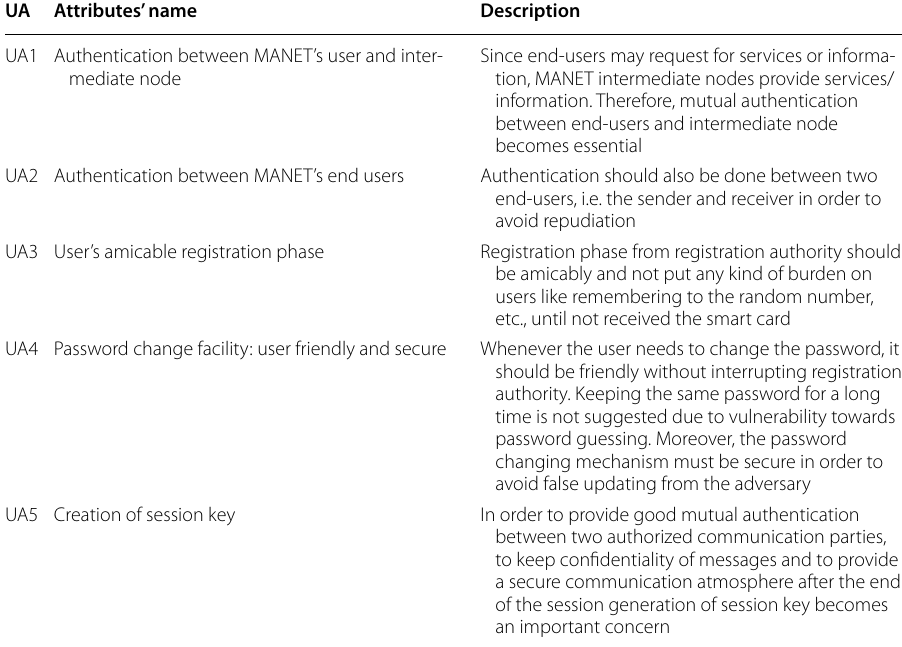
Table 2 Important usability attributes of authentication mechanism with its description UA Attributes’ name